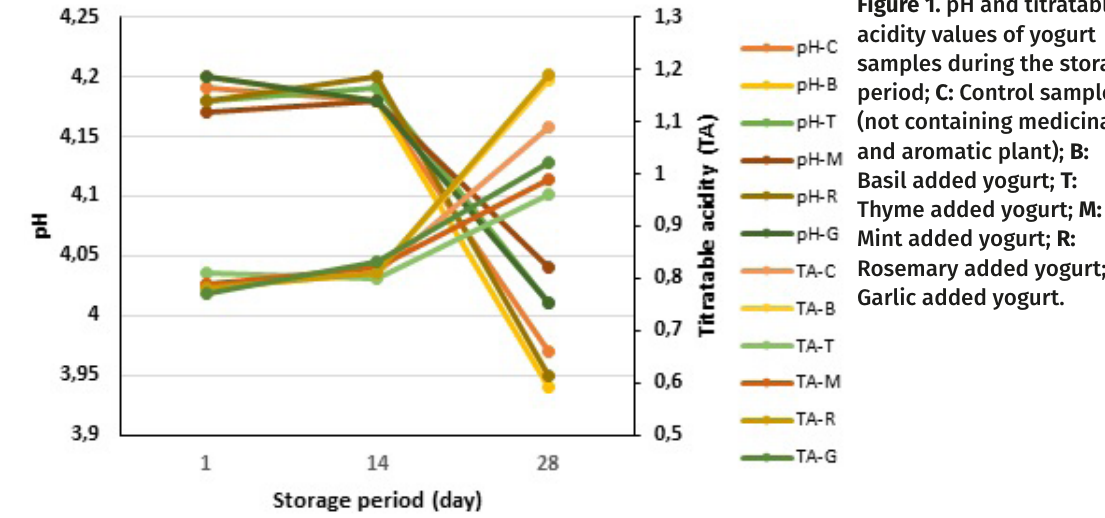
Figure 1. pH and titratable acidity values of yogurt samples during the